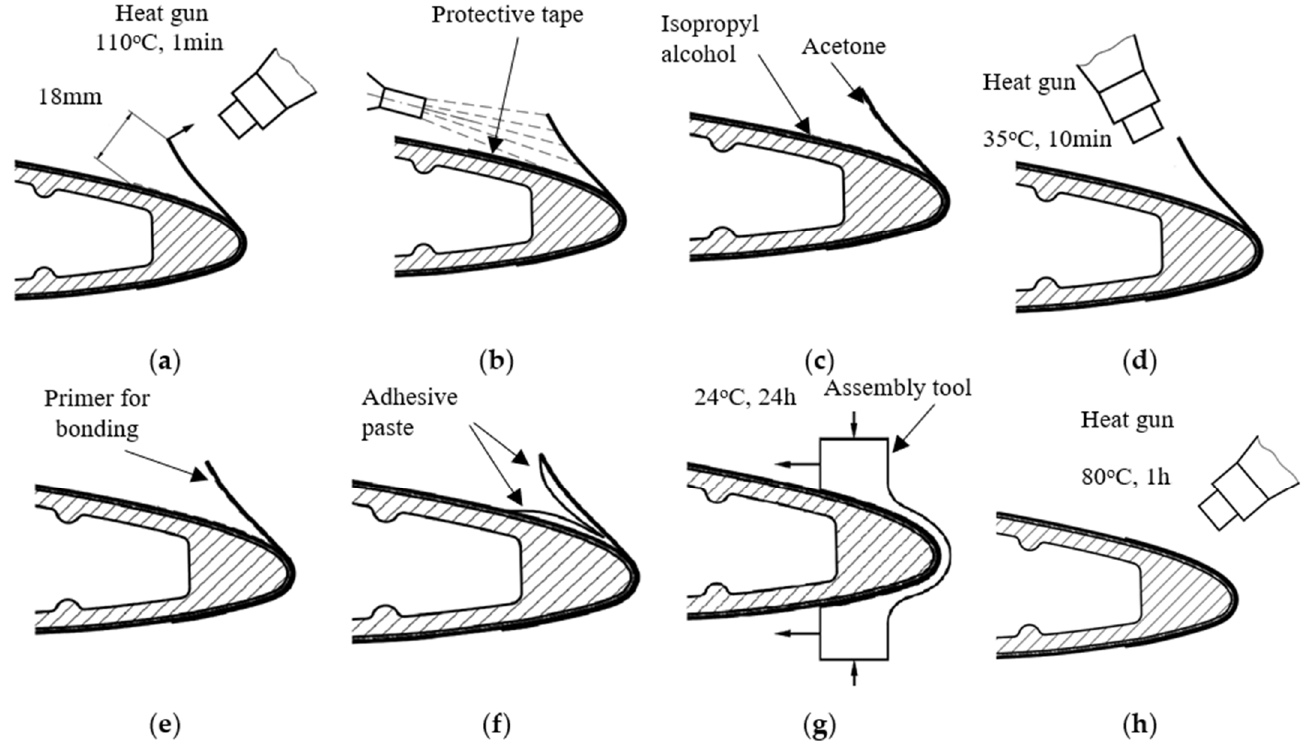
Figure 7. Technological process of repairing the leading edge of a rotor blade: ( a ) Separation of the damaged piece of shield from the rubber; ( b ) Sandblasting; ( c ) Cleaning; ( d ) Drying; ( e ) Applying a primer; ( f ) Applying adhesive paste; ( g ) Curing; ( h ) Post-curing.